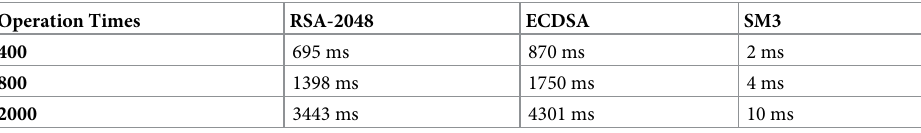
Table 3. Execution time of different algorithms at different operation